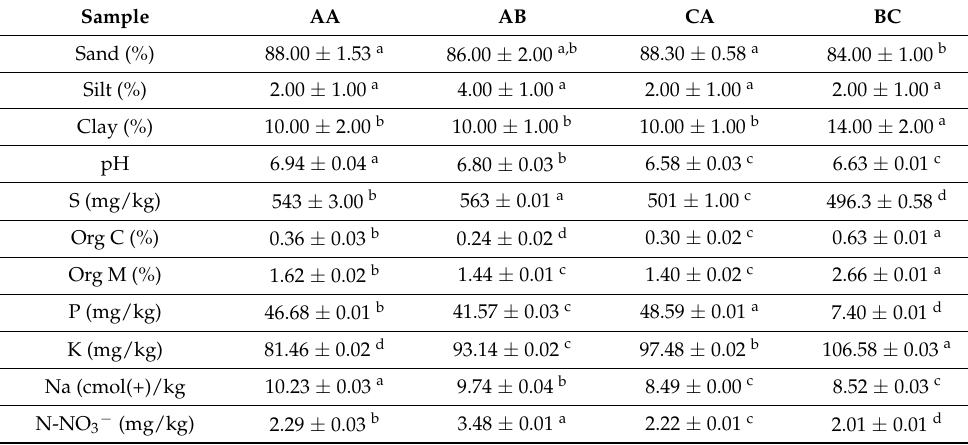
Table 1. The physical and chemical properties of the rhizosphere and bulk soil samples.